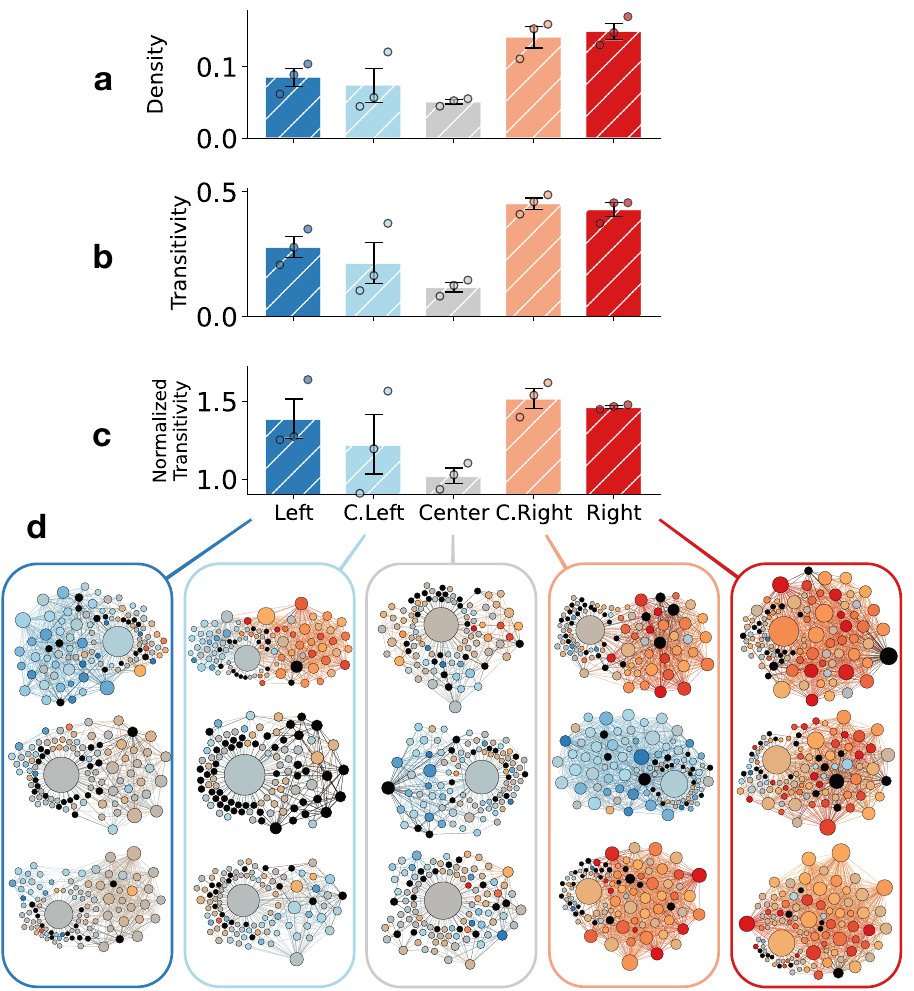
Fig. 2 Echo chamber structure around drifters. a Density, b transitivity, and c normalized transitivity of drifters ego networks in different groups. Error bars indicate the standard errors ( n = 3 drifters in each group). d Ego networks of the drifters in the fi ve groups. Nodes represent accounts and edges represent friend/follower relations. Node size and color represent degree (number of neighbors) and political alignment of shared links, respectively. Black nodes have missing alignment scores due to not sharing political content. Source data are provided as a Source data fi le.